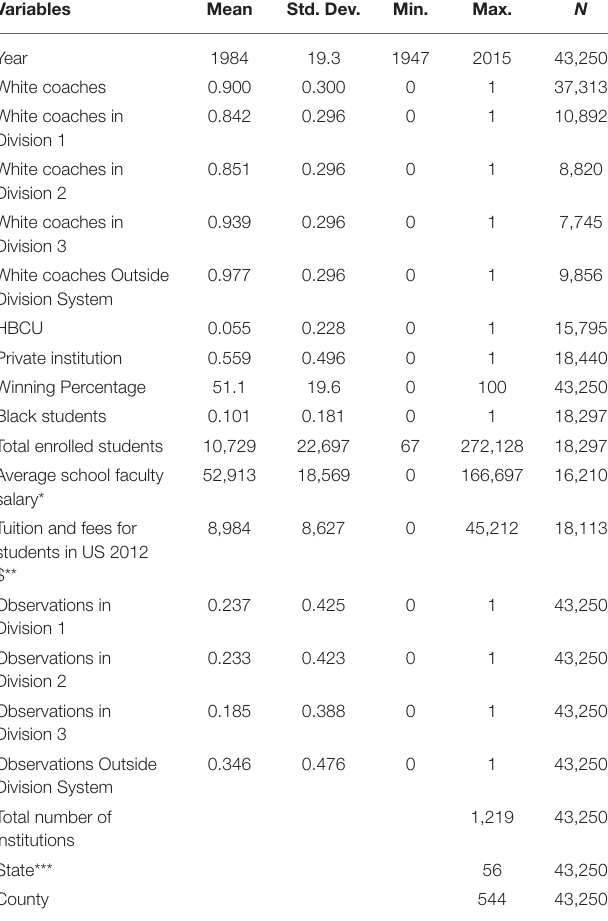
TABLE 2 | Descriptive statistics for